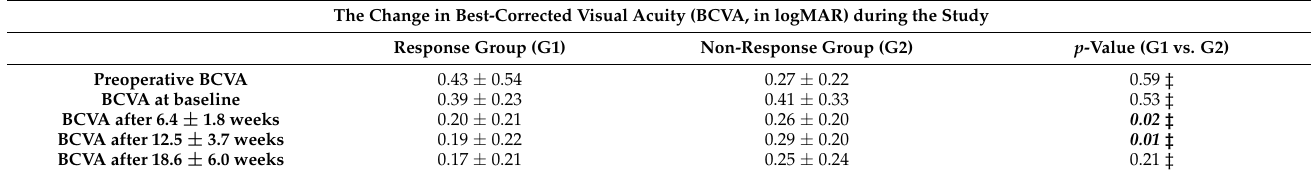
Response Group (G1) p -Value (G1 vs. G2)